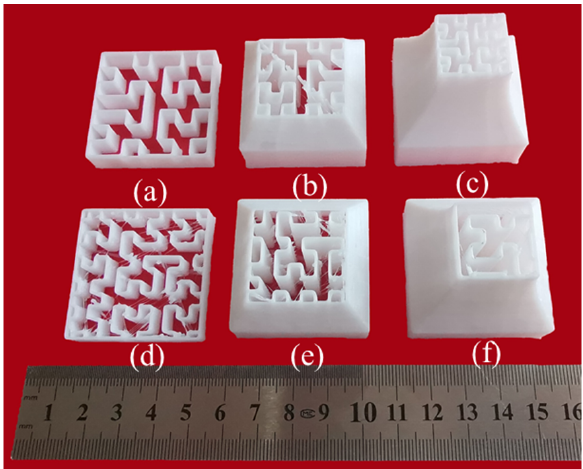
Figure 8. The cross-sections of the incomplete specimens with different heights: 10 mm ( a ), 25 mm ( b ), 40 mm ( c ) adaptive-density filling structure, 10 mm ( d ), 25 mm ( e ), 40 mm ( f ), uniform filling structure.